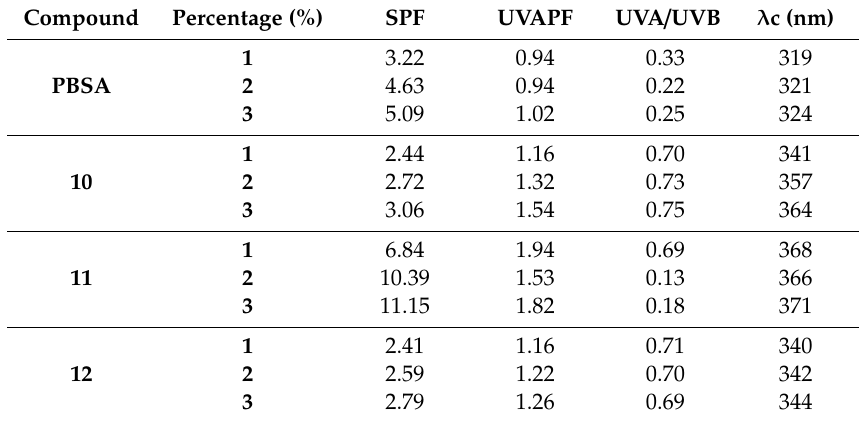
Table 1. UV filtering activity of benzimidazole derivatives 10 – 12 in formulation at di ff erent